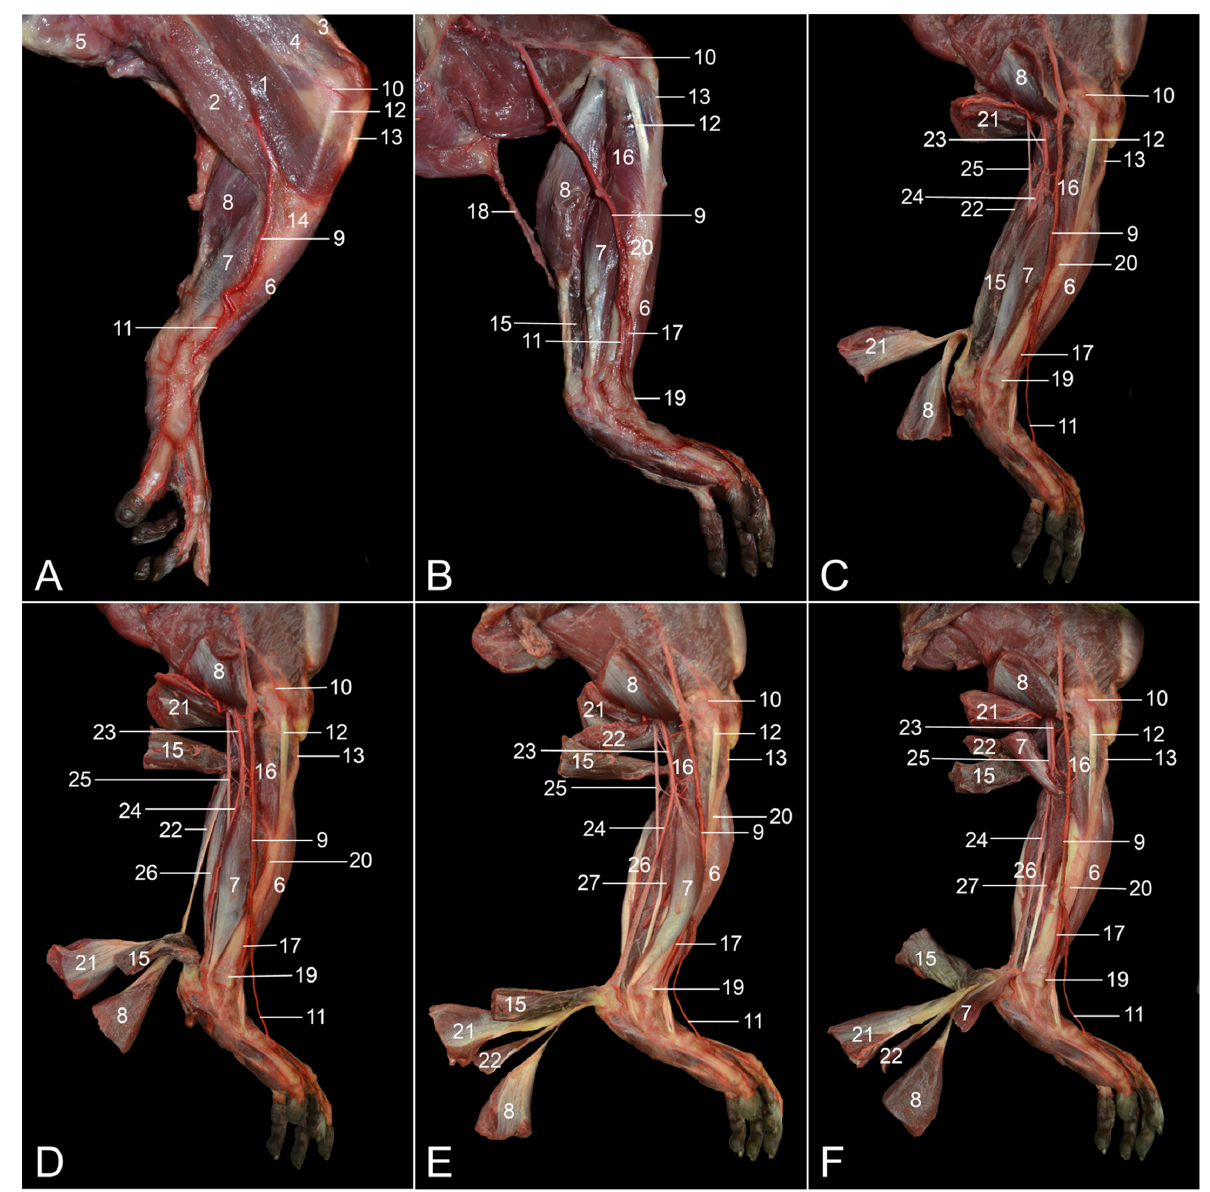
Figure 8. Medial views of the left lower hindlimb. ( A ) Superficial layer; ( B ) second layer after the m. sartorius and the m. gracilis were removed and the m. flexor digitorum medialis/tibialis was separated from the m. gastrocnemius caput mediale; ( C ) third layer after the m. gastrocnemius caput laterale, the m. gastrocnemius caput mediale and the v. saphena lateralis were transected and retracted; ( D ) fourth layer after the m. soleus was transected and its stumps were retracted; ( E ) fifth layer after the m. plantaris was transected and its stumps were retracted; ( F ) deepest layer after the m. flexor digitorum medialis/tibialis was transected and its stumps were retracted. 1: M. sartorius; 2: m. gracilis; 3: m. rectus femoris; 4: m. vastus medialis; 5: m. semimembranosus; 6: m. tibialis cranialis; 7: m. flexor digitorum medialis/tibialis; 8: m. gastrocnemius caput mediale; 9: a. saphena + v. saphena medialis + n. saphenus; 10: a. genus proximalis; 11: a. dorsalis pedis superficialis; 12: ligamentum collaterale mediale; 13: ligamentum patellae; 14: planum cutaneum tibiae; 15: m. soleus; 16: m. popliteus; 17: a. dorsalis pedis profunda; 18: v. saphena lateralis; 19: retinaculum proximale; 20: tibia; 21: m. gastrocnemius caput laterale; 22: m. plantaris; 23: a. + v. poplitea; 24: a. tibialis caudalis; 25: n. tibialis; 26: m. tibialis caudalis; 27: m. flexor digitorum lateralis/fibularis.